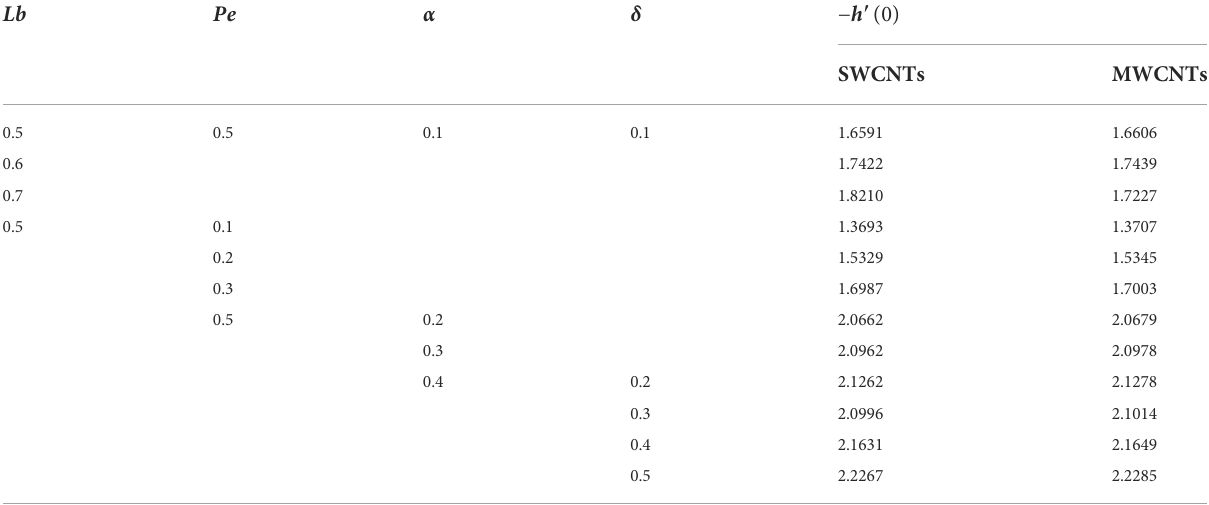
TABLE 4 Statistical outcomes of microorganism transmission rate − h 9 ( 0 )